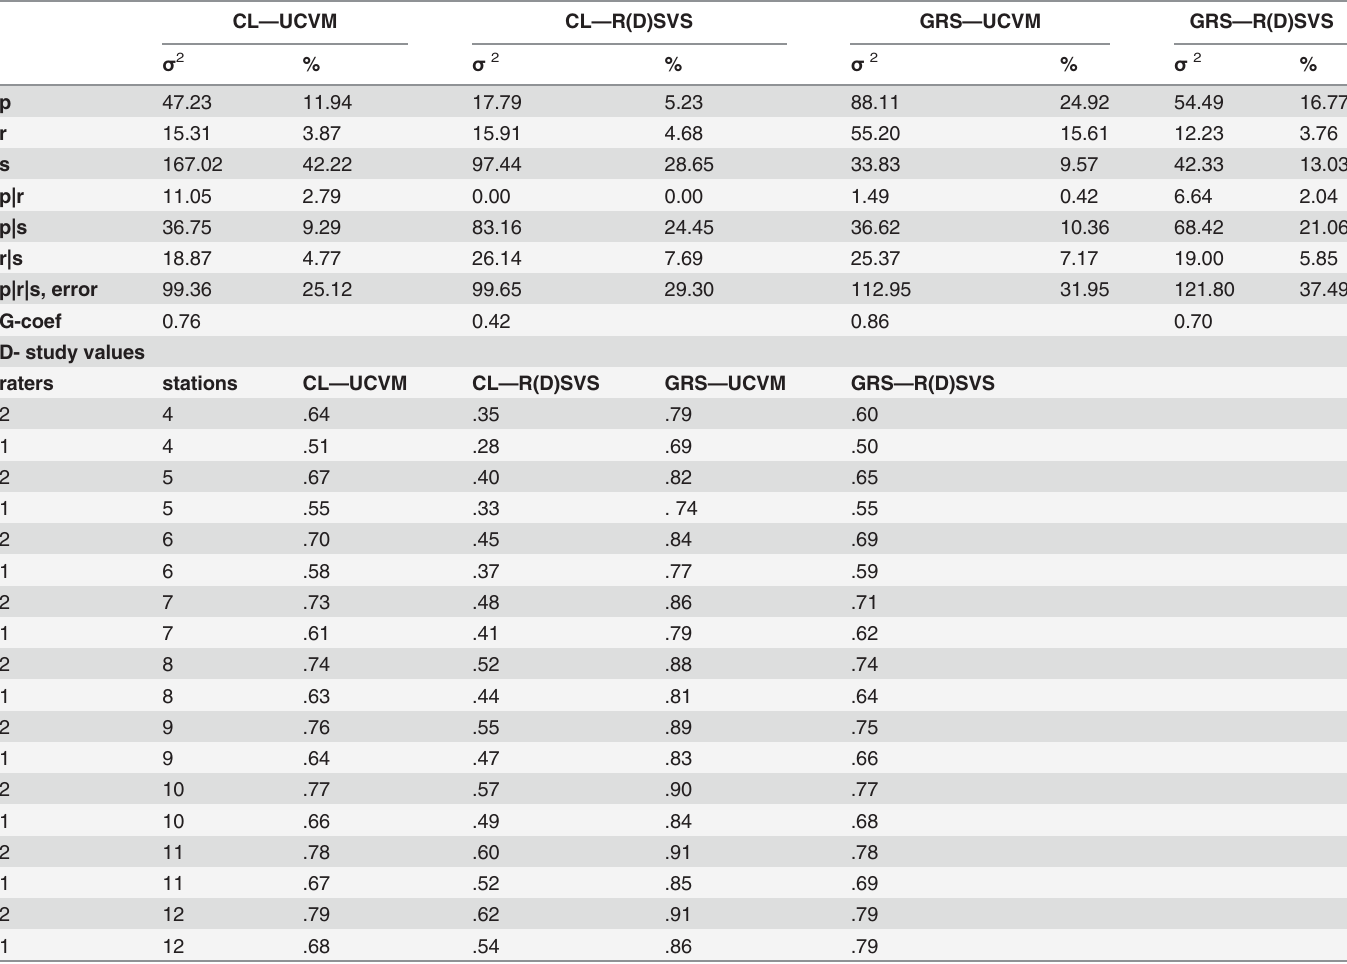
Table 2. Generalizability (G) study (for participant (student) (12), rater (6) and station (4)) and Decision (D) study with reliability coefficient (G-coef) calculated using the variance components. CL —